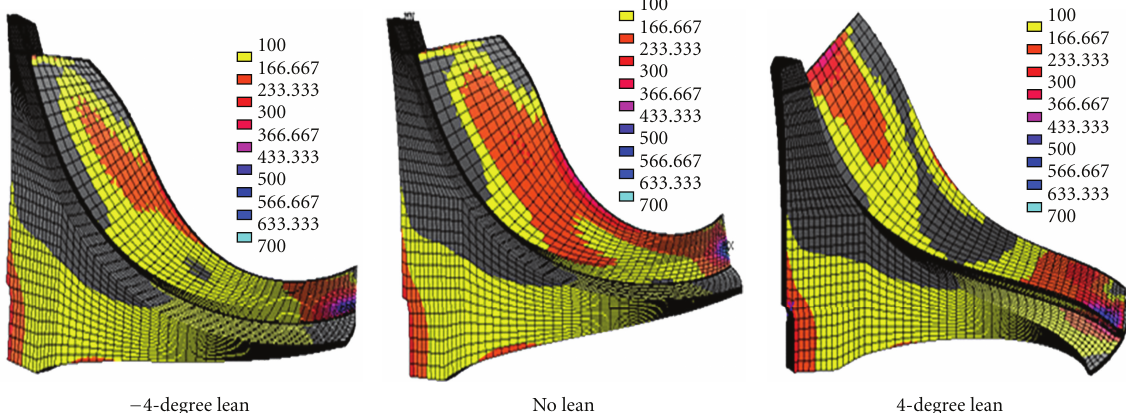
Figure 18: Von Mises stress at the pressure side of the wheel.